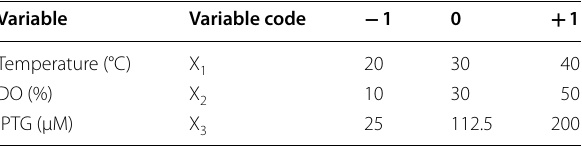
Table 1 Coded and real values for the Box–Behnken design